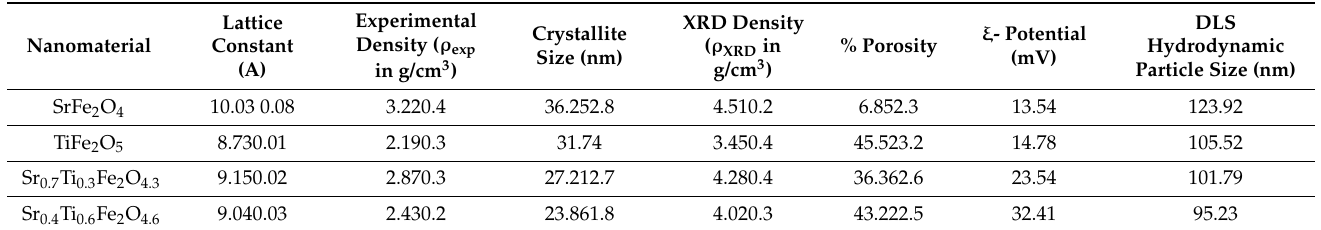
Table 1. XRD parameters, ξ - potential and DLS hydrodynamic particle size of SrFe 2 O 4 , TiFe 2 O 5